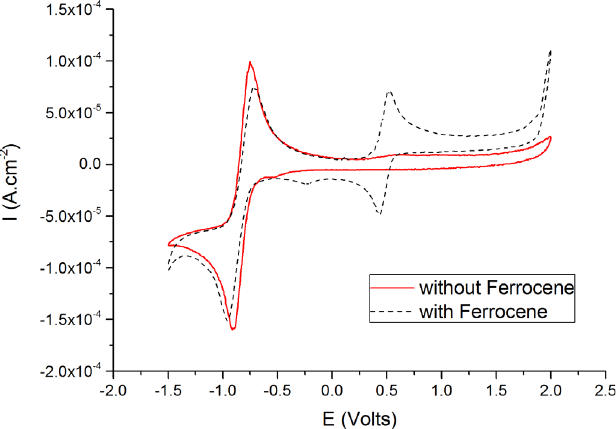
Fig. 2. CV scan of RhBT in acetonitrile with 0.1M t-butylammoniumhexa fl uorophosphate as electrolyte and ferro- cene